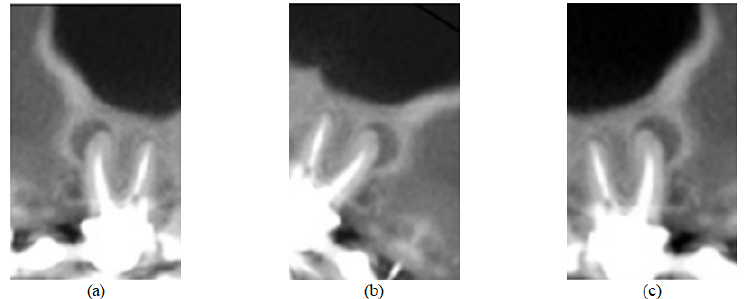
Figure 3. Image of Figure 2e submitted to the three data augmentation techniques used in this work. In ( a ), there is the application of the horizontal flip technique; in ( b ), the rotation technique was applied; and in ( c ), a zoom